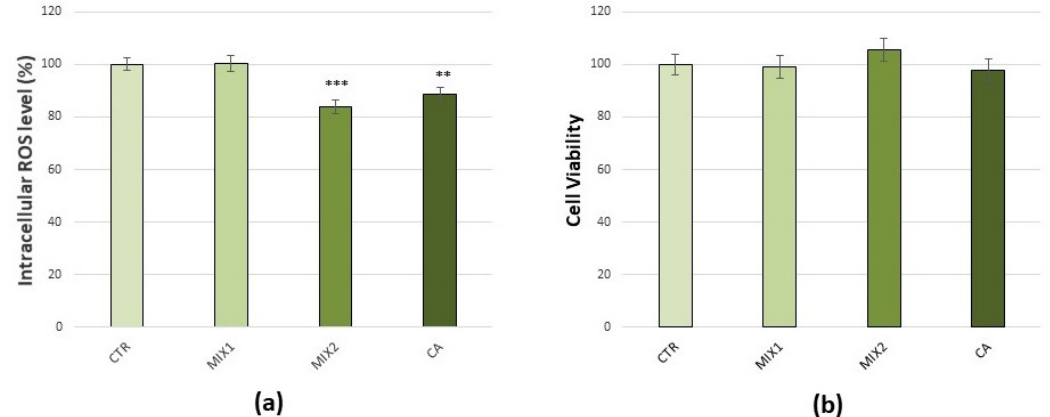
Figure 4. Effects of coffee phenolic metabolites in C6 glioma cells. ( a ) Intracellular DCF fluorescence intensity of cells treated with 0.5 µ M Mix 1, 1 µ M Mix 2, or 1 µ M caffeic acid (CA) for 48 h. ( b ) Cell viability of cells treated with 0.5 µ M Mix 1, 1 µ M Mix 2, or 1 µ M caffeic acid for 48 h. Values represent mean ± SE obtained from three independent experiments. ** p < 0.01 versus control, *** p < 0.001 versus control.